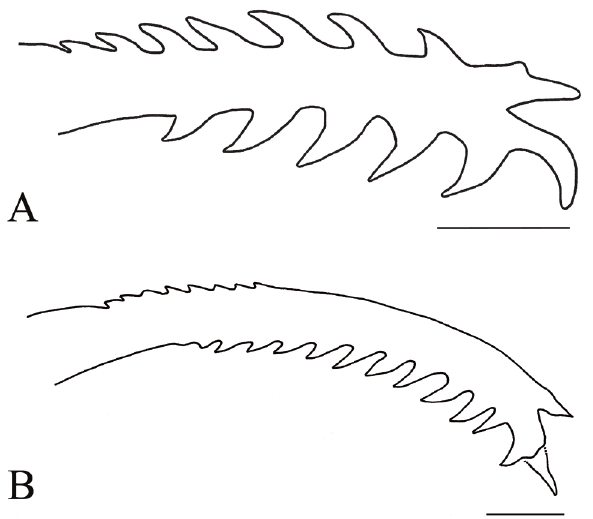
FIGURE 3 | Pectoral-fin spine: A. Left, ventral view of Rhyacoglanis rapppydanielae , paratype, INPA 7957, 33.3 mm SL, rio Tocantins, state of Pará, Brazil, scale bar = 1 mm; and B . Right, dorsal view of Rhyacoglanis seminiger , holotype, LIRP 12466, 74.2 mm SL, scale bar = 2.0 mm (after Shibatta, Vari, 2017).